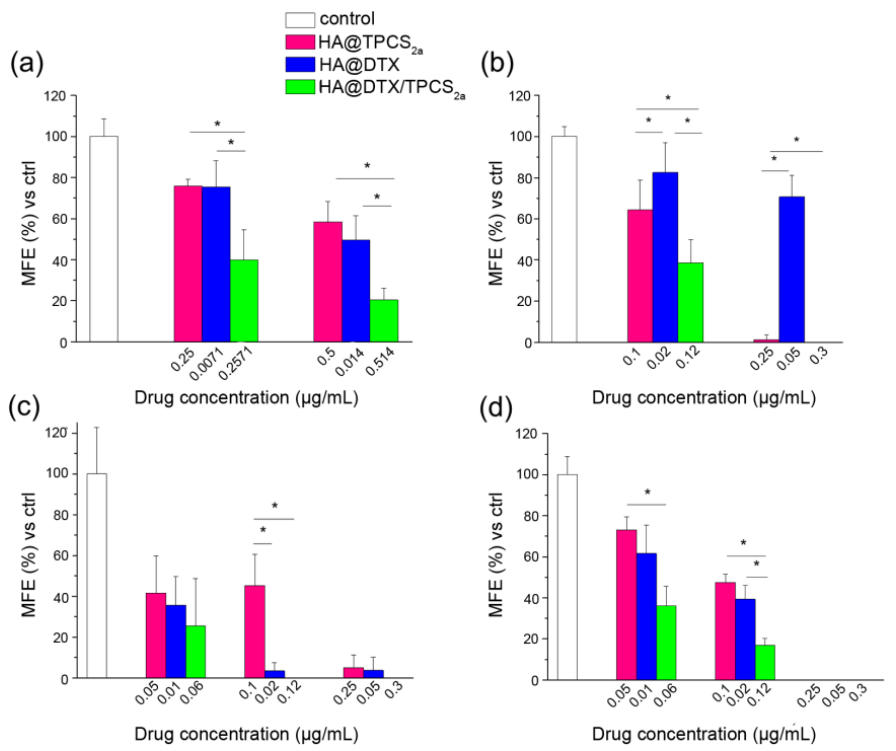
Figure 3. Mammosphere formation efficiency (MFE) after HA-NPs treatments. Percentage MFE measured in first generation mammospheres generated from MDA-MB-231 ( a ) and MCF-7 ( c ) monolayered cells incubated for 24 h with HA@DTX-NPs, HA@TPCS 2a -NPs and HA@DTX/TPCS 2a -NPs, irradiated with 1 J/cm 2 , and re-seeded in non-adherent conditions to allow formation of spheres (protocol 1). Percentage MFE measured in second generation mammospheres generated from first generation mammospheres of MDA-MB-231 ( b ) and MCF-7 ( d ) exposed to drug-loaded NPs for 24 h, irradiated with 1 J/cm 2 , and re-seeded in non-adherent conditions (protocol 2). MFE was evaluated after 7 and 4 days from re-seeding for MCF-7 and MDA-MB-231, respectively. Data are expressed as mean ± S.D. of at least two independent experiments, carried out in triplicate; * p < 0.05 (one-way ANOVA, Bonferroni’s correction).